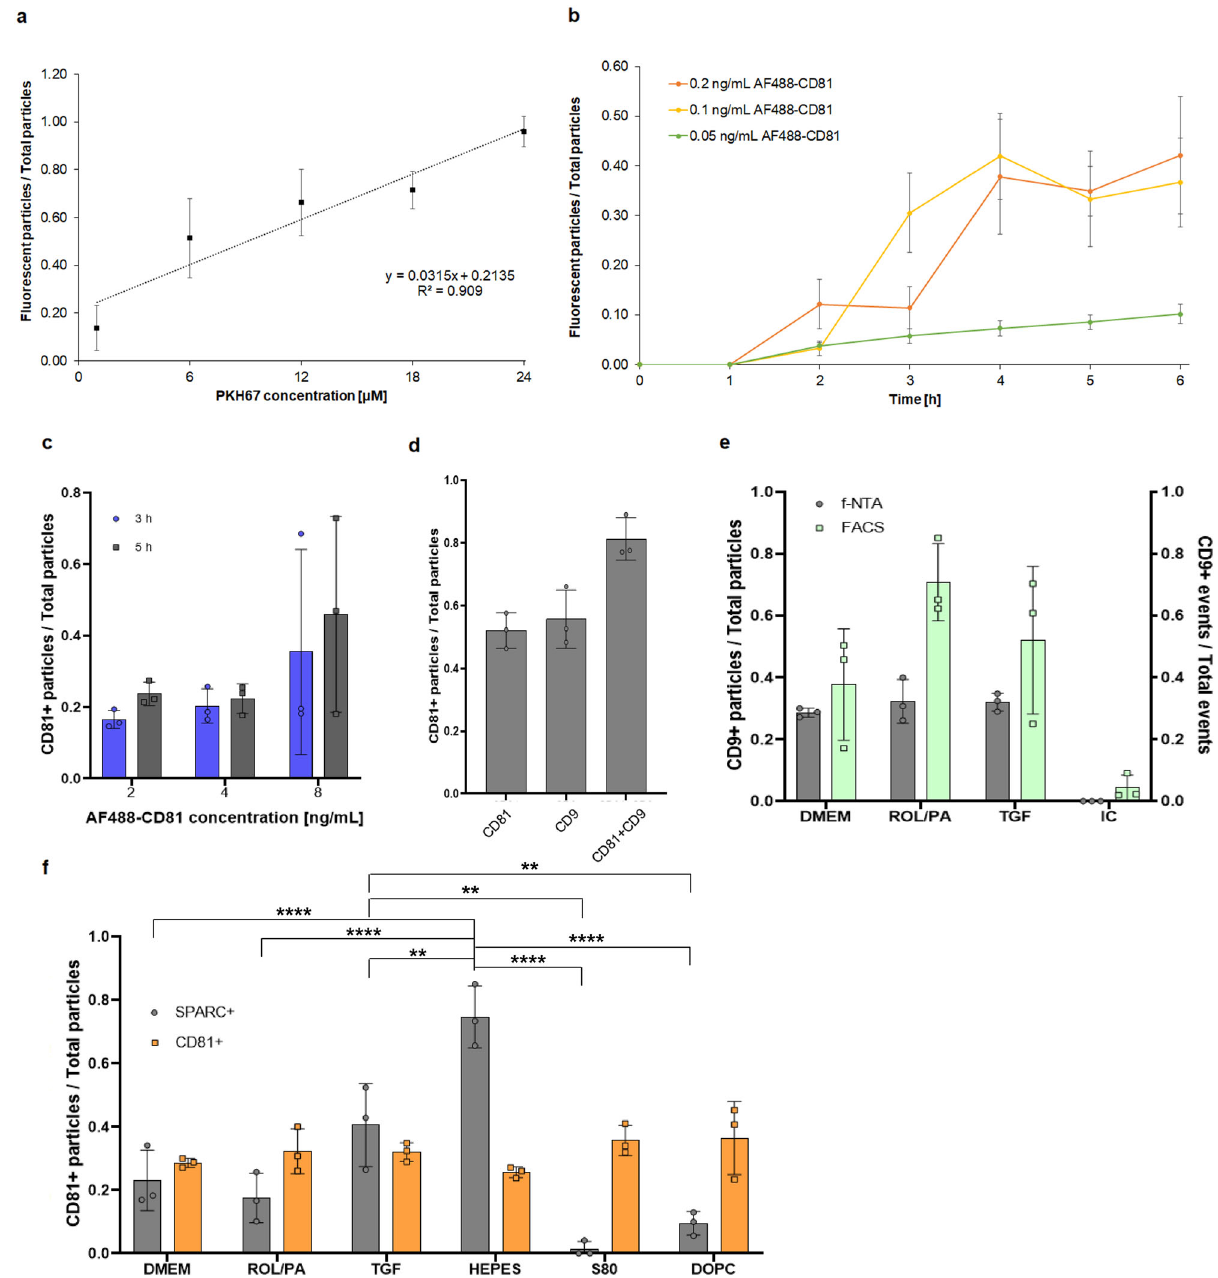
Fig. 6 Feasibility of f-NTA for the detection of physiologically relevant proteins. a SEC-puri fi ed EVs stained with unspeci fi c membrane dye PKH67 by systematically increasing dye concentrations. b SEC-puri fi ed EVs incubation with varying amounts of AF488-CD81 and for different times at 24 °C. c , d EV- containing pellets incubated with AF488-CD81 prior to SEC and detected after puri fi cation ( c ) and comparison with additional incubation with AF488-CD9 ( d ). e Direct comparison of CD9 detection by f-NTA and FACS using EVs from differently treated LX-2, including isotype control (IC). f Detection of SPARC and CD81 on EVs isolated from differently treated LX-2 cells following the optimized f-NTA protocol (mean ± SD, n = 3). P values ( p ≤ 0.05 (*), p ≤ 0.01 (**), p ≤ 0.001 (***), and p ≤ 0.0001 (****)) were determined by one-way ANOVA on ranks and Tukey ’ s multiple